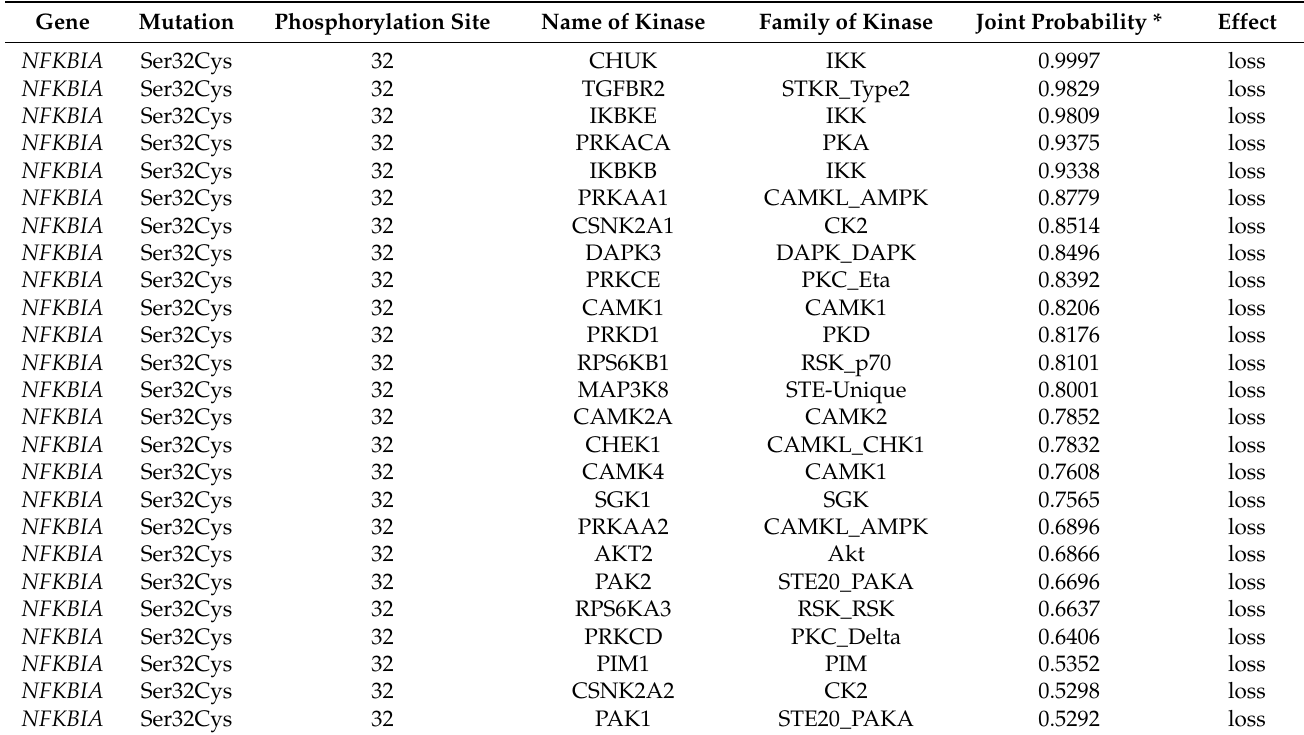
Table 2. The impact of Ser32Cys mutation on kinase–substrate interactions by the mutations impact on phosphorylation (MIMP) server.